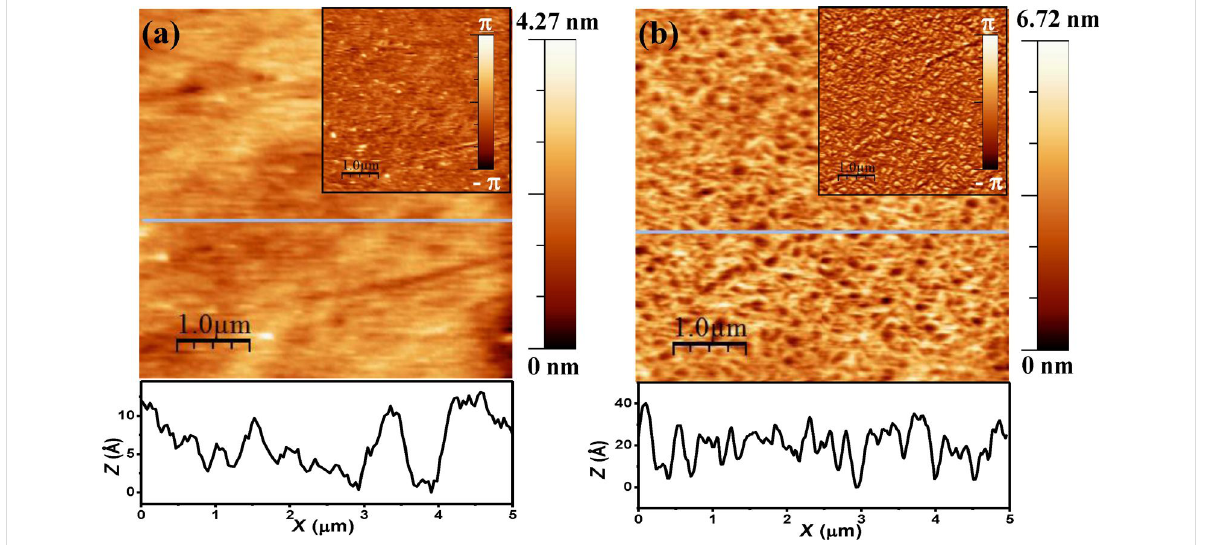
Figure 2: AFM height image of (a) Cu(II)-piroxicam-DNA film (scan size 5 μ m × 5 μ m) and (b) Cu(II)–piroxicam–DNA–buffer film (scan size 5 μ m × 5 μ m). Insets (a) and (b) show corresponding phase images. Lower panel shows the corresponding line profiles along the blue lines drawn on respective height